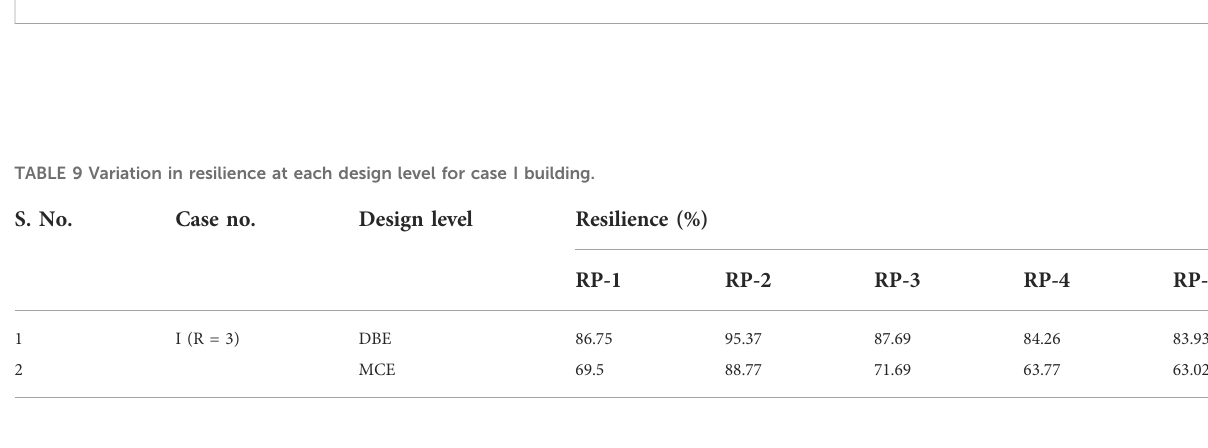
FIGURE 10 Functionality curves for case IV building with respect to various recovery paths. (A) Functionality curves using different recovery paths at DBE design level. (B) Functionality curves using different recovery paths at MCE design level.